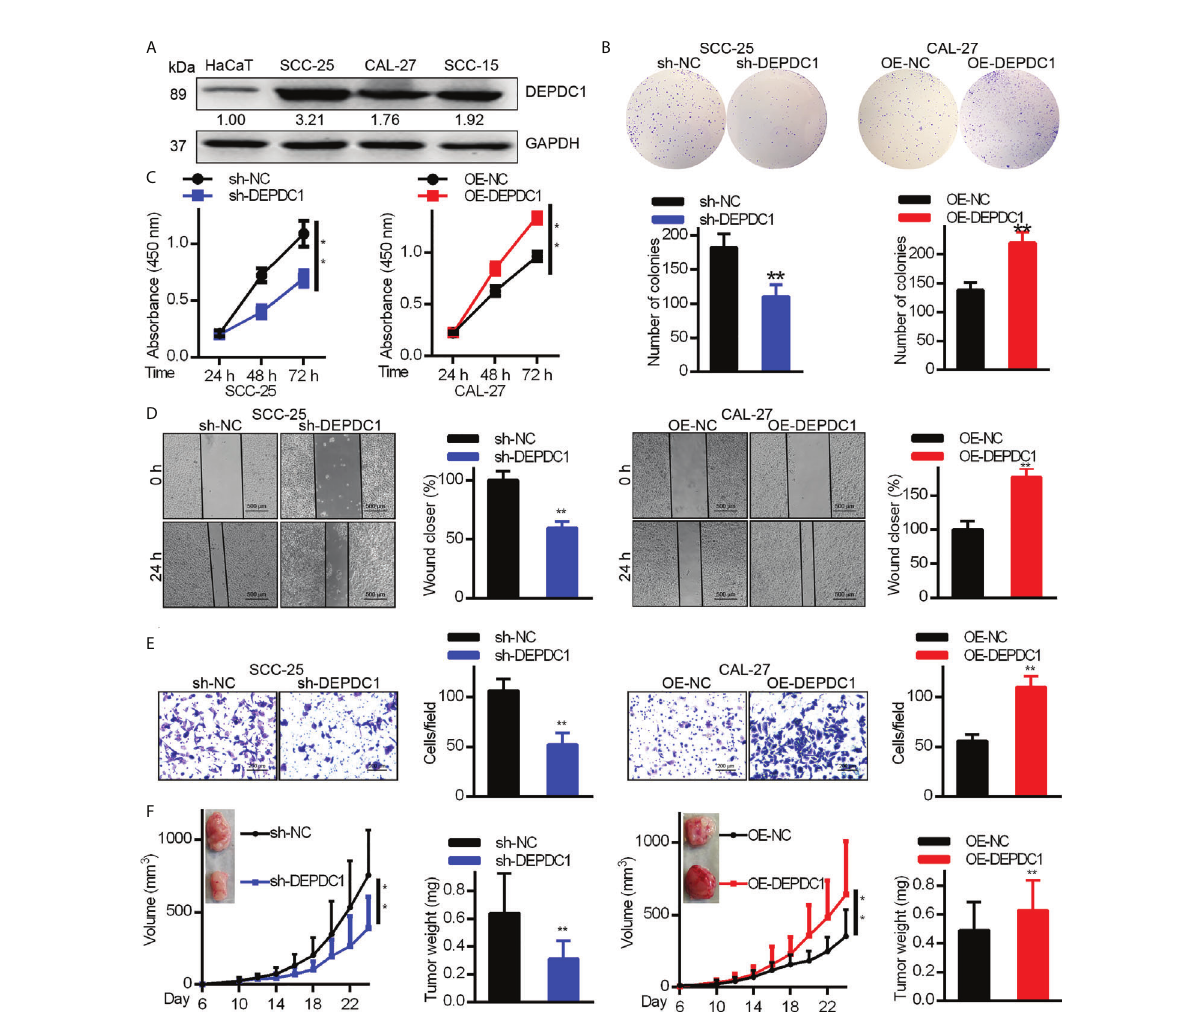
FIGURE 2 DEPDC1 promotes human OSCC cell tumorigenicity. (A) The expression of DEPDC1 in the HaCaT immortal keratinocyte cell line and three cell lines of OSCC (SCC-15, CAL-27 and CAL-25) was assessed with Western blot. Results were standardized to the GAPDH loading control. (B) SCC-25 cells had DEPDC1 knocked down, while in CAL-27 cells, it was overexpressed. (B, C) The colony formation study was studied by the Cell counting kit 8 (CCK-8). (D) A wound-healing test was performed. (E) Migration was measured using a Transwell assay. The fi gure-panels quantify and compare the number of cells going through the membrane and the proportion of wound closure. Scale bars are 500 µm (D) and 200 µm (E) . The results are shown as mean ± S.D. P < 0.05, ** P < 0.01, N = 3. (F) Each of 6 nude mice aged 6 weeks had 1 × 10 6 control or DEPDC1-knockdown SCC-25 cells injected under their skin. Weights and volumes of tumours were analyzed. Similarly, 1.5 × 10 6 control or DEPDC1-knockdown CAL-27 cells were injected under the skin of 6 nude mice. The weights and volume of the tumours were analyzed. For (F) A student ’ s t-test was used to compare tumor weights between 2 groups, whereas the two-way ANOVA was performed for larger groups. The data are presented as the mean±SD, and are representative of at least 3 independent